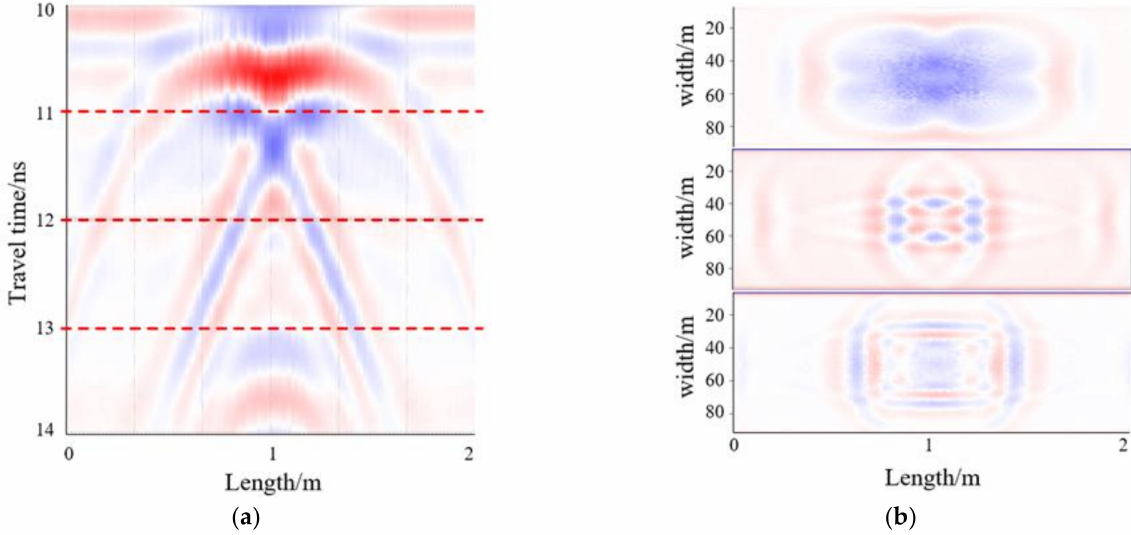
Figure 5. Typical GPR images of a rectangular cavity: ( a ) B-scan image; ( b ) C-scan